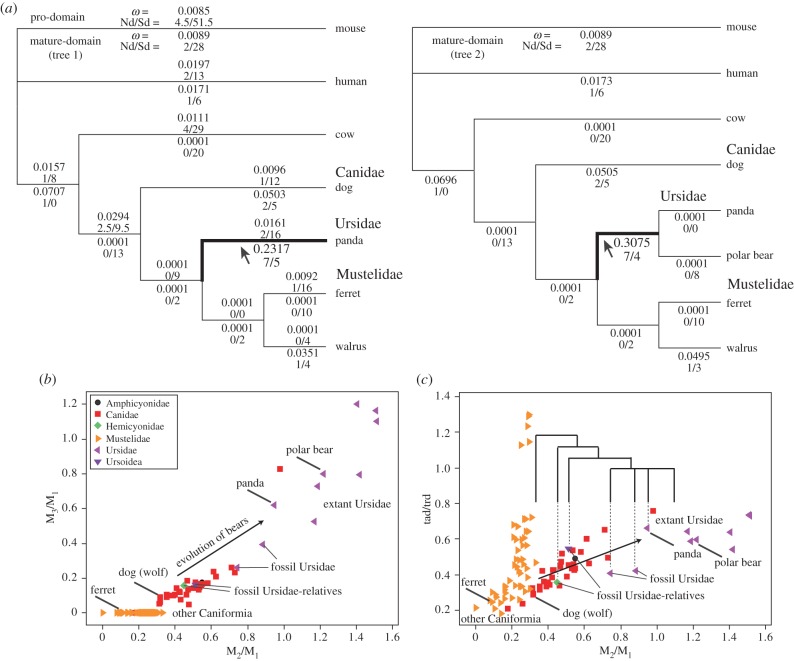
Evolution of BMP7 and dental evolution in ursids. (a) The non-synonymous to synonymous rate ratio (ω) for each branch, calculated based on the free-ratio model. The estimated numbers of non-synonymous substitutions and synonymous substitutions (Nd/Sd) are also shown based on the ancestral nucleotide sequences inferred using the Bayesian method. The pro-domain and the mature-domain were analysed separately. For the mature-domain, we calculated Nd and Sd using two different trees. In both trees, the mature-domain of BMP7 evolved under relaxed purifying selection only in the ancestral ursid branch (shown as boldface; pointed to with an arrow). (b) Plots of M2/M1 versus M3/M1 for ursids and other Caniformia. (c) Plots of M2/M1 versus tad/trd for these taxa. Species used for the molecular evolutionary analysis and fossil species important for ursid evolution are marked. Evolution of dentition in ursids is depicted from the lower left to the upper right areas in these plots, similar to the Bmp7-hetero-deficient mice. Fossil Ursidae-relatives and fossil Ursidae plotted between dog/ferret and panda, indicating that ursid dentition evolved gradually from the ancestral pattern of caniforms to that of present ursids associated with the evolution of BMP7.